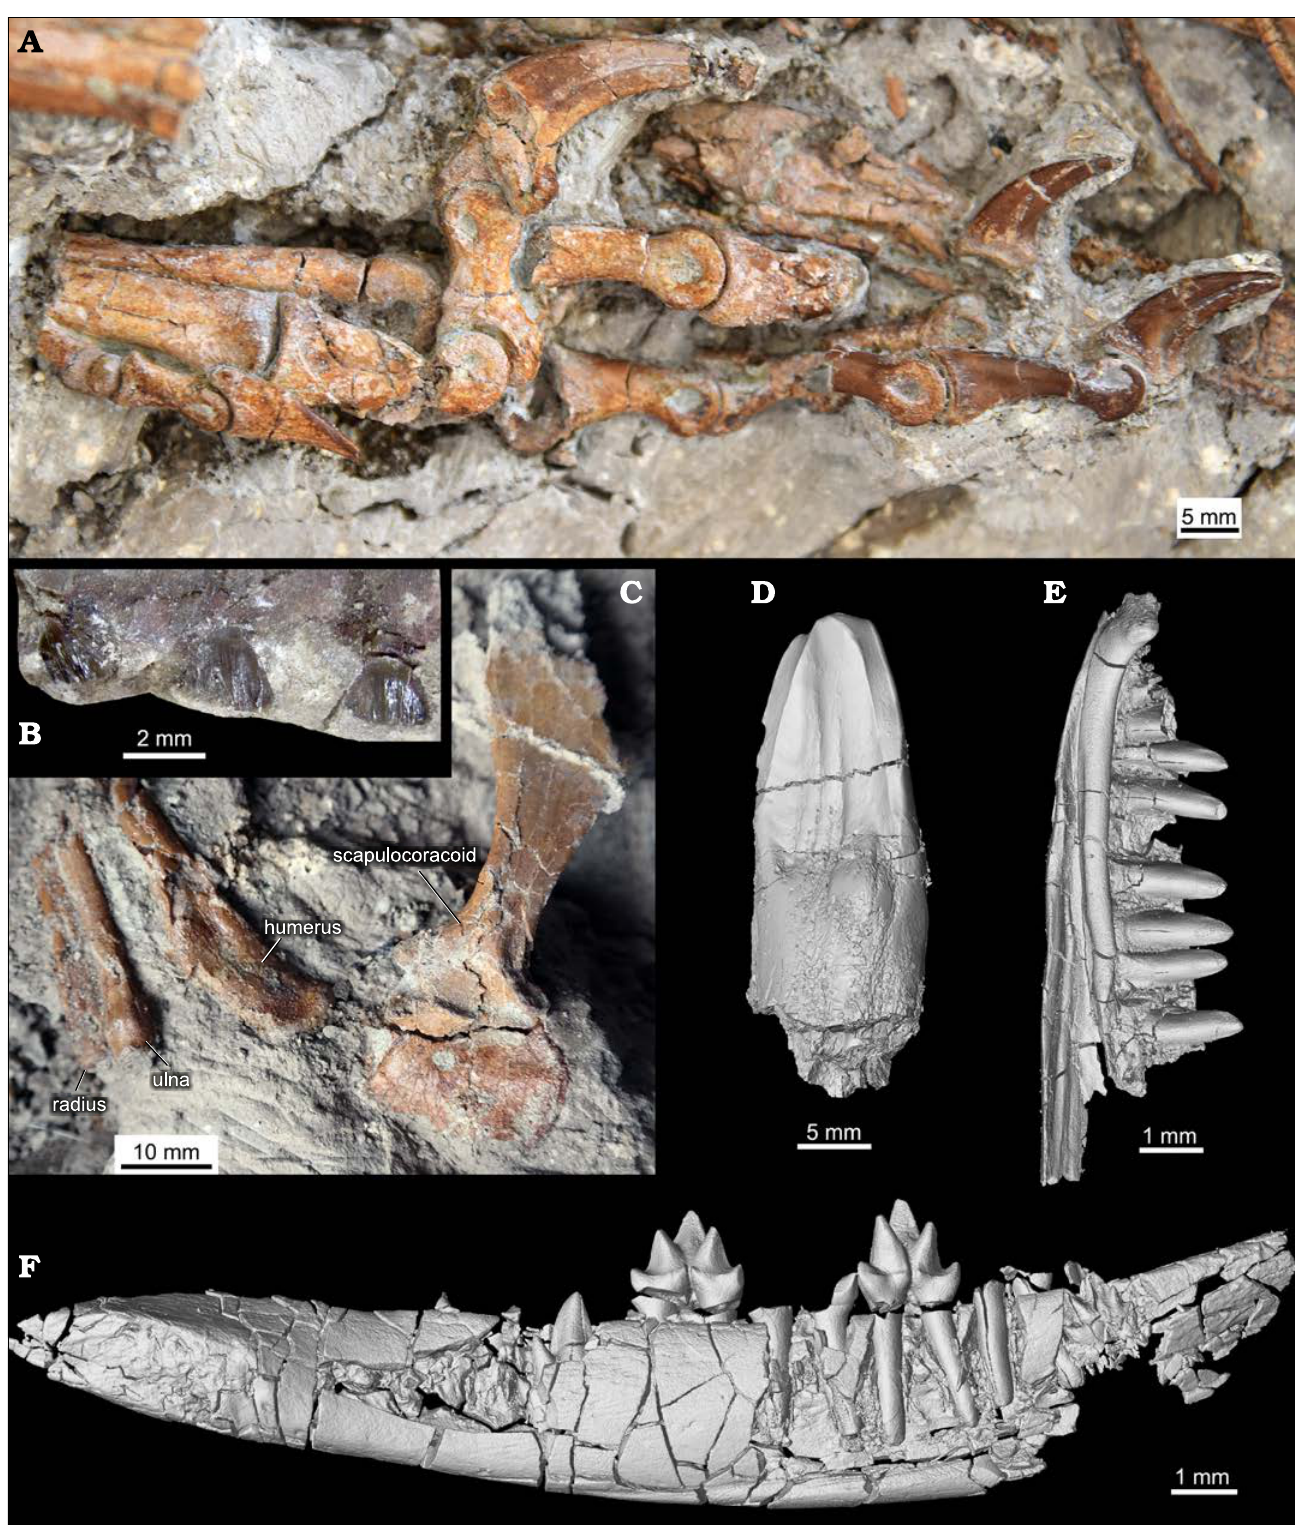
Fig. 2. Fossils found in the Xidayingzi site from the Early Cretaceous Ningcheng Basin, Inner Mongolia. A . Sinovenator -like troodontid dinosaur (SDUST-V1062), the left pes is exposed in medial view. B . Ceratopsian dinosaur Psittacosaurus sp. (PMOL-AD00163), the maxilary teeth are loosely arranged and exposed in lateral view. C . Neornithischian dinosaur Jeholosaurus sp. (SDUST-V1063), the scapulocoracoid, humerus, ulna, and radius in lateral view. D . Euhelopus -like sauropod (SDUST-V1064), digital image of the tooth crown in medial view. E . Indeterminated lizard (PMOL- AR00268), digital image of the fragmentary mandible in lingual view. F . Symmetrodont-like mammal (PMOL-AM00036), digital image of the man- dible in lingual